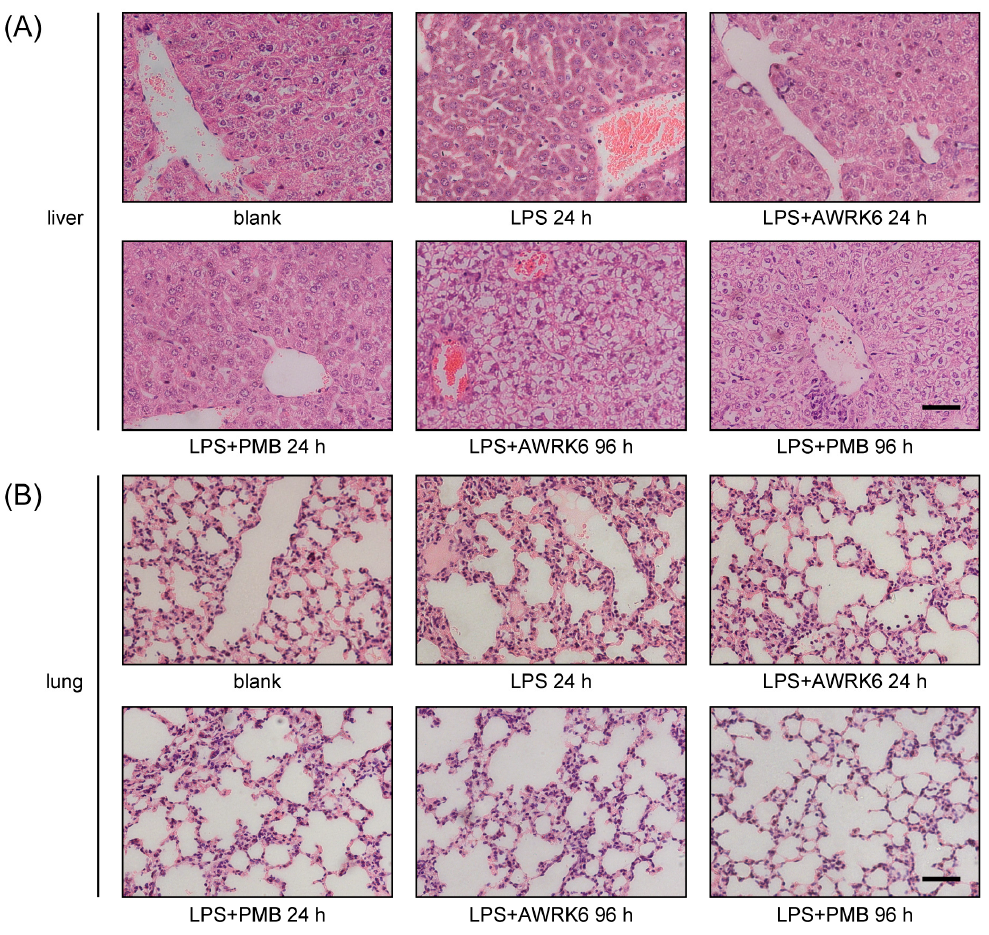
Figure 3. AWRK6 protected liver and lung injury in endotoxemia mice. ( A ) Histopathological analysis of HE-stained sections from liver in endotoxemia mice. ( B ) Histopathological analysis of HE-stained sections from lung in endotoxemia mice. PMB was used as a positive control. Bar indicates 100 nm.